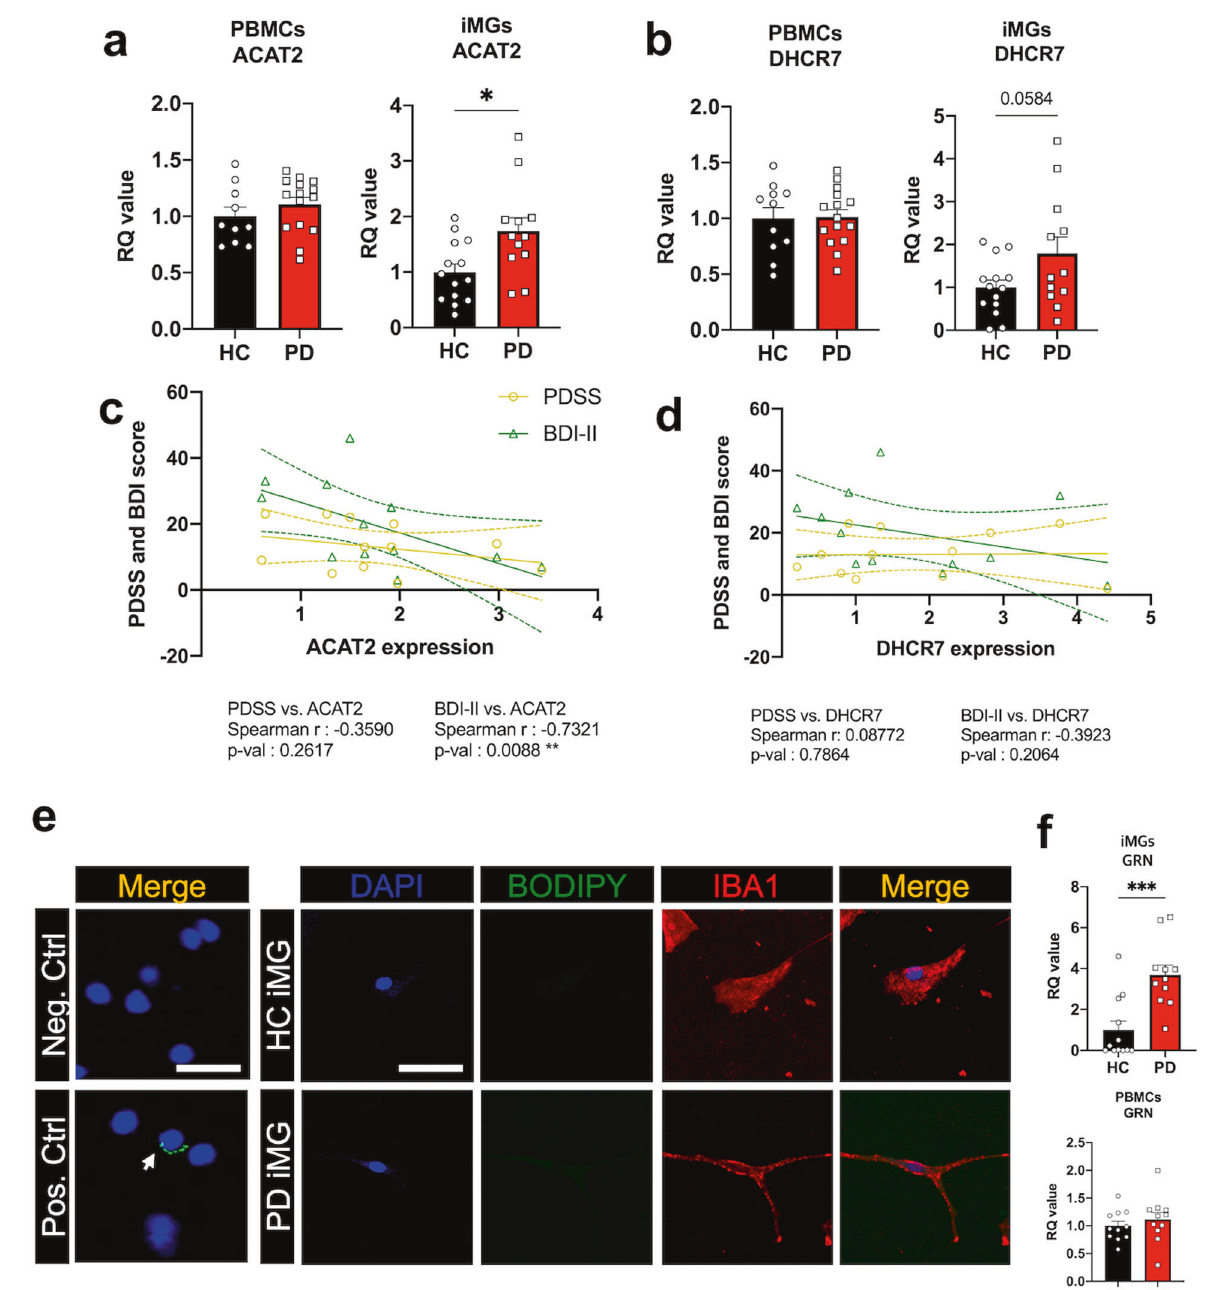
Fig. 4 Novel targets based on the transcriptome of PD-iMGs and their clinical relevance. a , b qRT-PCR analysis for cholesterol biosynthesis genes in PBMCs and iMGs of both HC and PD. c , d Correlation analysis between ACAT2 and DHCR7 mRNA expression levels and clinical indicators of panic symptoms. e The representative images (40x) of BODIPY-stained BV2 cells and iMGs. LPS-treated and non-treated BV2 cells were used for positive and negative controls, respectively. Scale bar = 50 um. f qRT-PCR analysis of GRN expression in PBMCs and iMGs respectively. To compare statistical signi fi cance between the two groups, we conducted an unpaired t test and spearman correlation analysis. * P < 0.05, ** P < 0.01, and *** P <